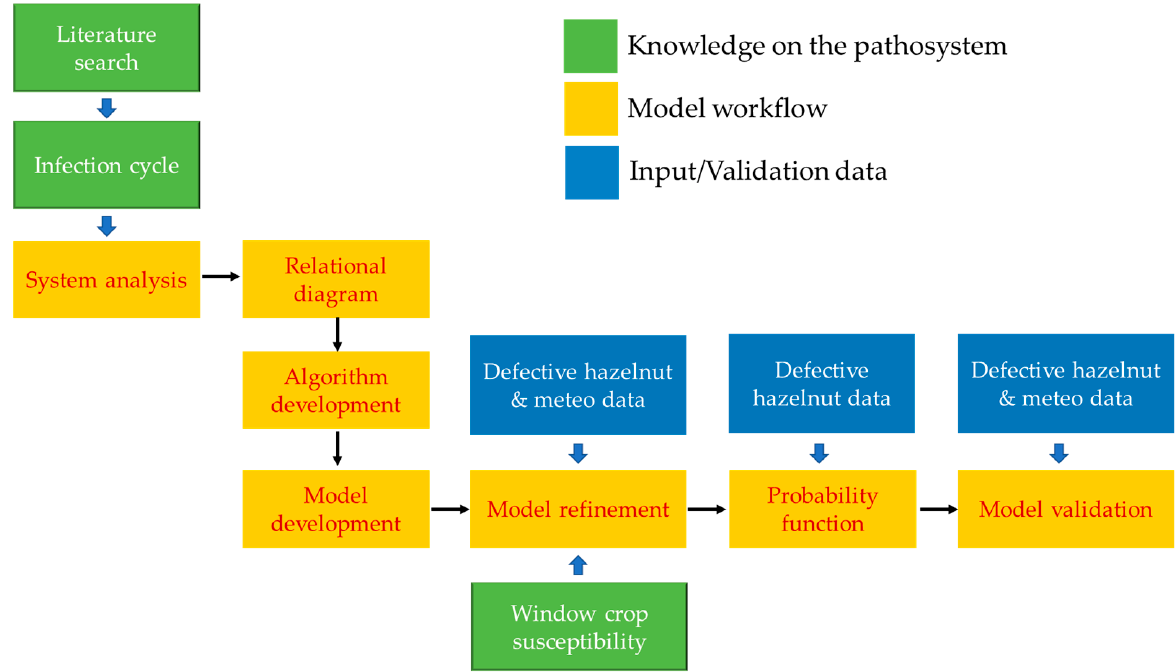
Figure 3. Workflow of study. Pathway for model development reported in yellow boxes (“Model workflow”), input data sources (DH and meteorological data) reported in blue boxes (“Input/Vali- dation data”), and “Knowledge on the pathosystem”, referring to knowledge on D. eres infection cycle and hazelnut crop susceptibility, reported in green boxes.